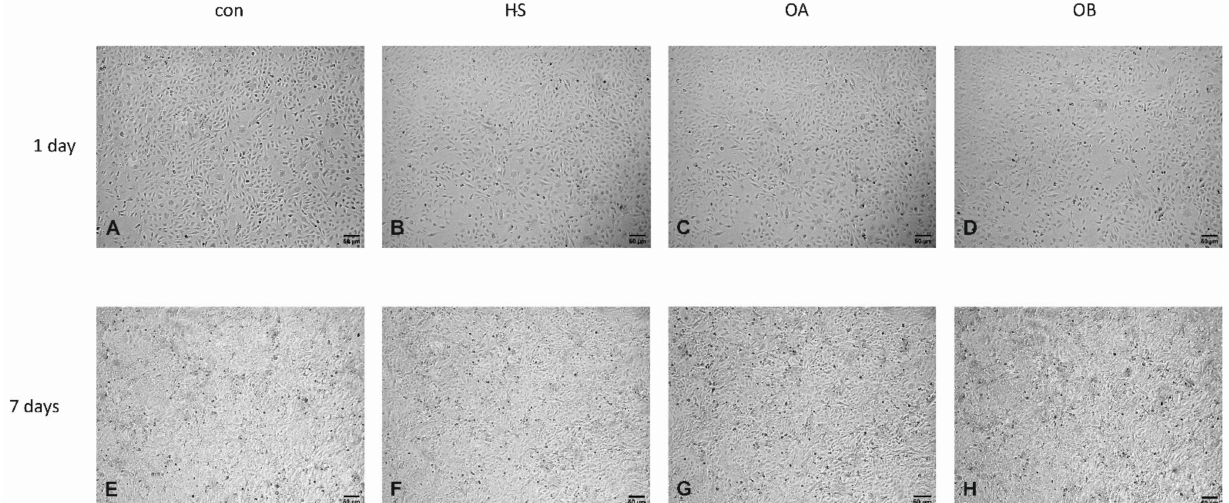
Figure 4. Light microphotographs of HUVEC line EA.hy926 after one ( A – D ) and seven days ( E – H ) of exposition to medium supplemented with: foetal calf serum (CON), human serum taken from healthy patients (HS), human pooled serum taken from obese patients with dyslipidaemia before the administration of flaxseed (OA), human serum taken from obese patients with dyslipidaemia after a 10-weeks dietary supplementation with flaxseed (OB). Magnification 100 × .